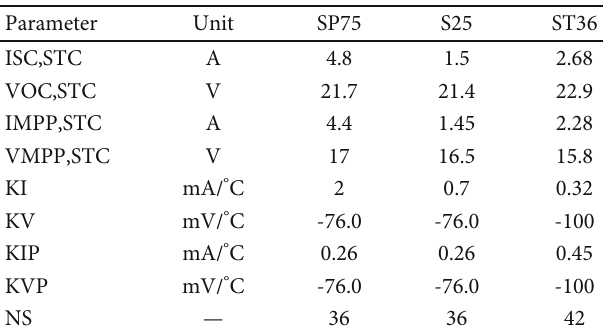
Table 1: Parameters of three kinds of PV